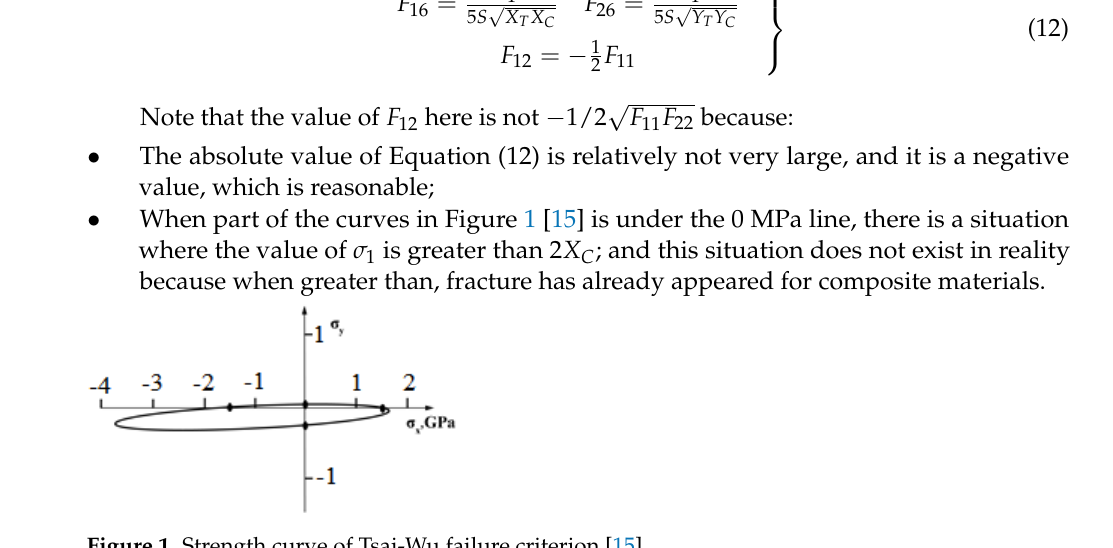
Figure 1. Strength curve of Tsai-Wu failure criterion [15].